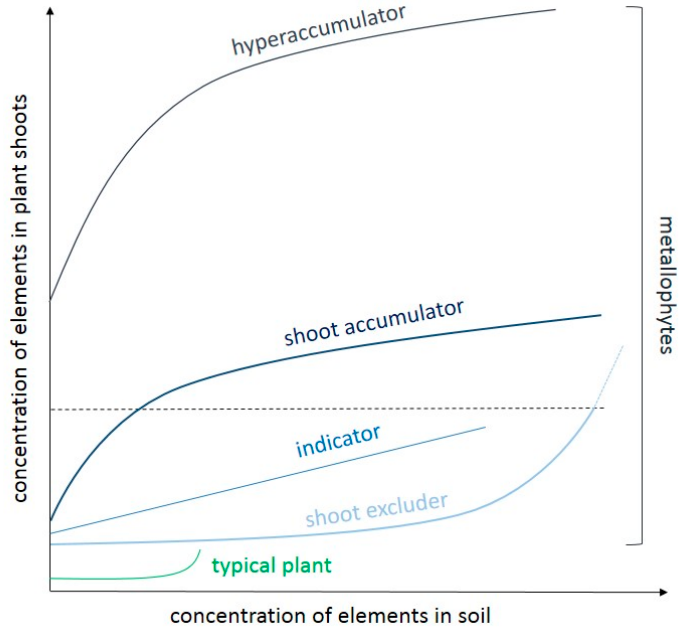
Figure 3. Conceptual response diagram demonstrating the potential relationship between the concentration of metals / metalloids in aerial parts of the plant and available content of metals / metalloids in the soil. Modified from van der Ent et al. [14]. The dotted line showes the hyperaccumulator threshold for the different metallic.